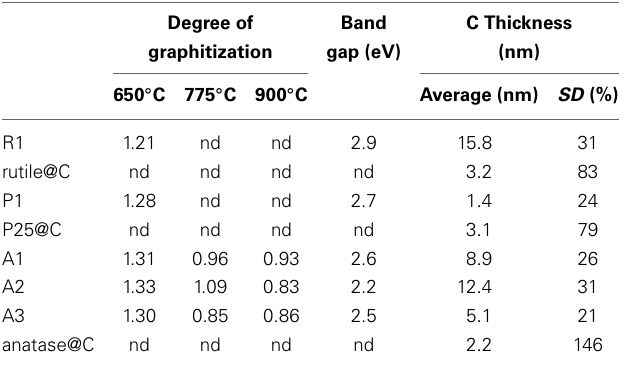
FIGURE 3 | TiO 2 @C (TiO 2 = anatase) nanoparticles prepared by a conventional hydrothermal synthesis, following the procedure of (Olurode et al., 2012). The arrows outline carbon